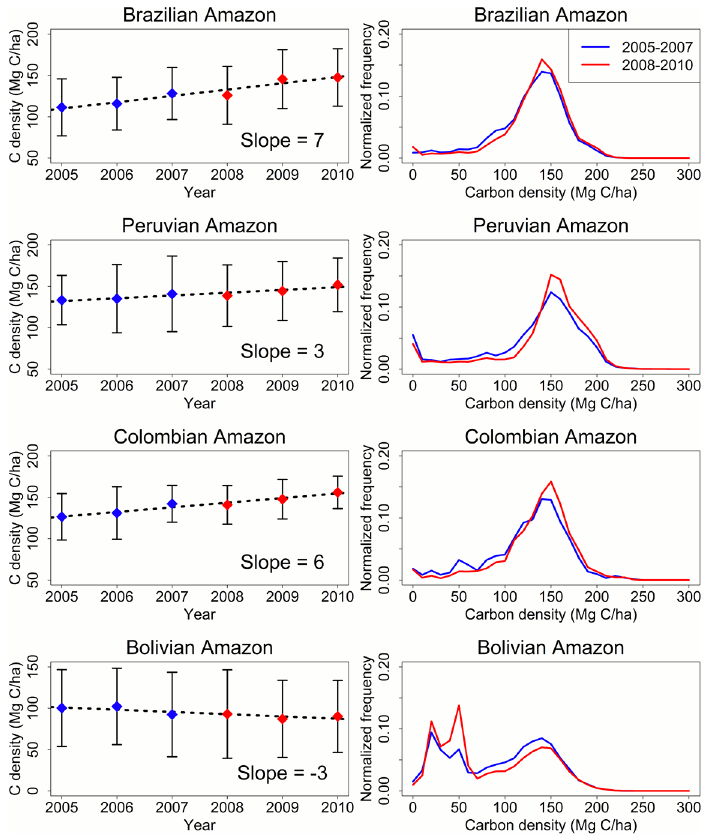
Fig 6. Carbon density of lost forests between 2005 and 2010. The left column shows trends in different regions over time. Blue and red diamond dots represent the mean value, with vertical bars representing ± one standard derivation. Dotted lines represent the linear fit of mean values. The right column shows distributions of carbon density, aggregated to two time periods 2005 – 2007 (blue lines) and 2008 – 2010 (red